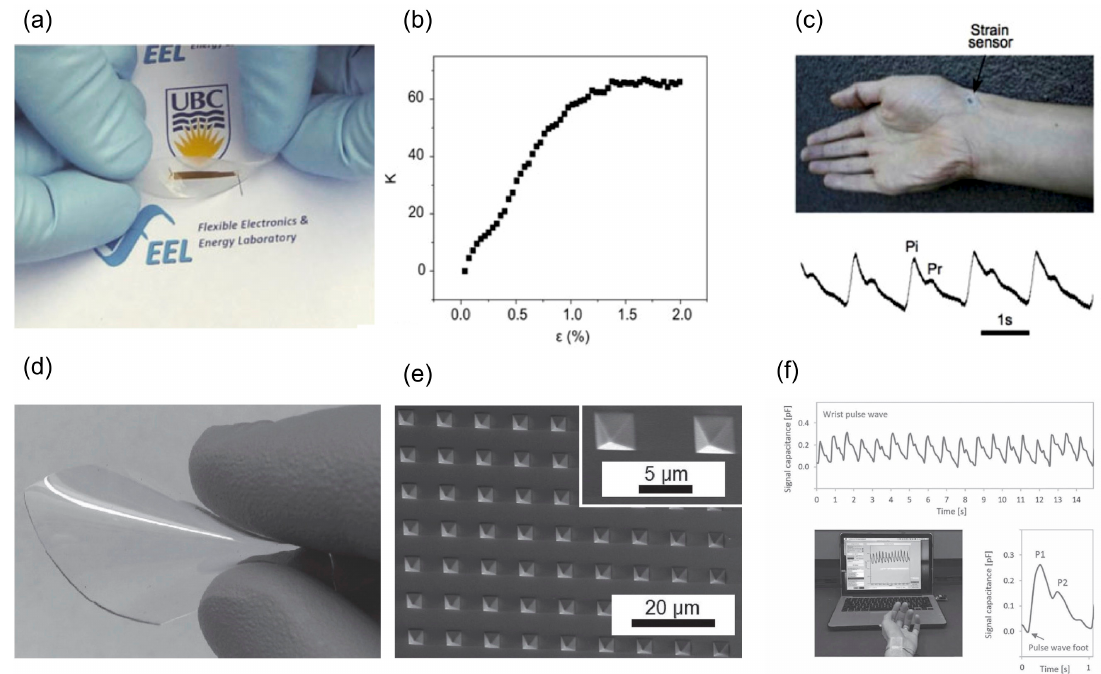
Figure 4. Application of strain and pressure sensors for heart rate monitoring: ( a ) flexible piezoresistive strain sensor fabricated by electrospinning and encapsulated in PDMS; ( b ) exceptional gauge factor of 60; and ( c ) detection of heart rate and pulse waveform by attaching the sensor on radial artery (Reprinted with permission [13]. Copyright 2014, Cambridge University Press); ( d ) flexible pressure sensing film; and ( e ) array of micro-pyramid shape structures fabricated on poly(glycerol sebacate) (PGS); ( f ) Blood pulse wave of the radial artery detected by the pressure sensor (Reprinted with permission [14]. Copyright 2015, John Wiley and Sons).